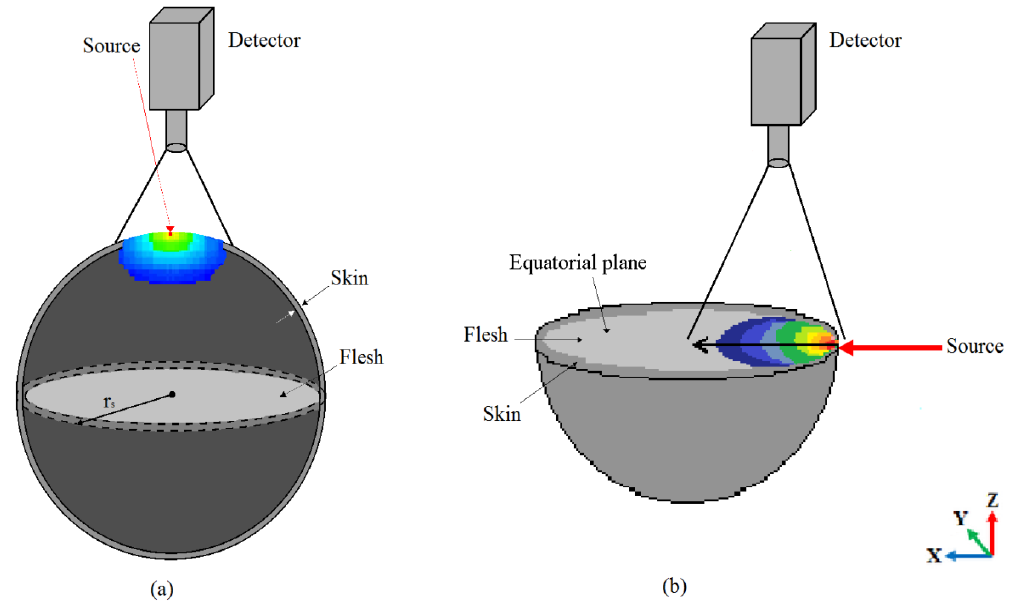
Figure 1. Apple models and imaging-tissue setups used for the Monte Carlo simulations. ( a ) Whole apple assimilated to a sphere (flesh) surrounded by a thin layer of tissue (skin), and observed over its top curved boundary. ( b ) Half-cut spherical apple model observed over its equatorial plane. In both cases, the Gaussian beam size of the incident light source is 2 ω 0 = 1